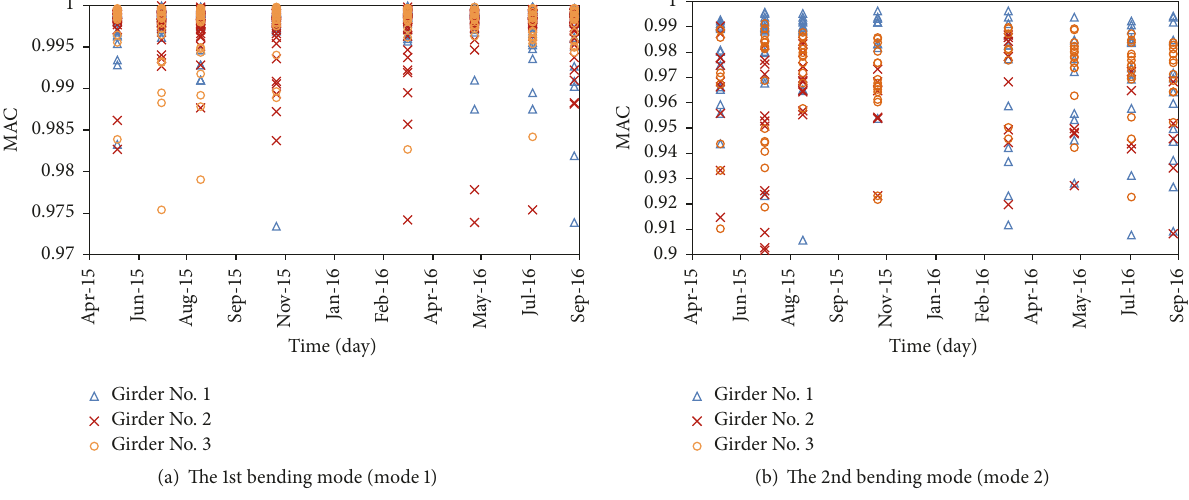
Figure 21: ((a)-(b)) Time histories of MAC values for three